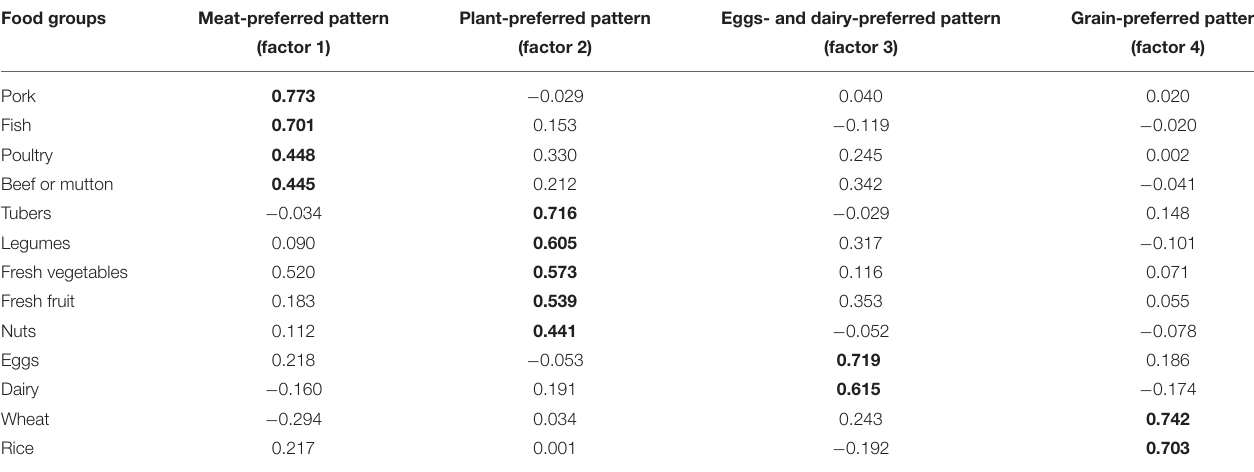
TABLE 2 | Factor load in food groups of dietary patterns a .